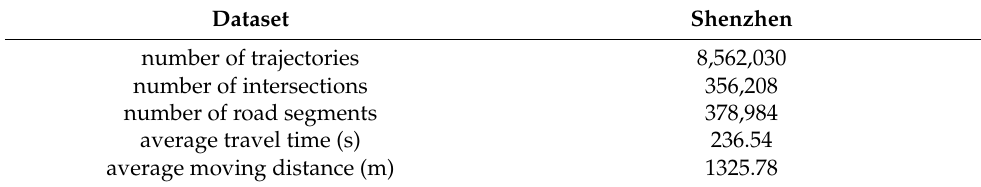
Table 2. The numerical statistics of real-world